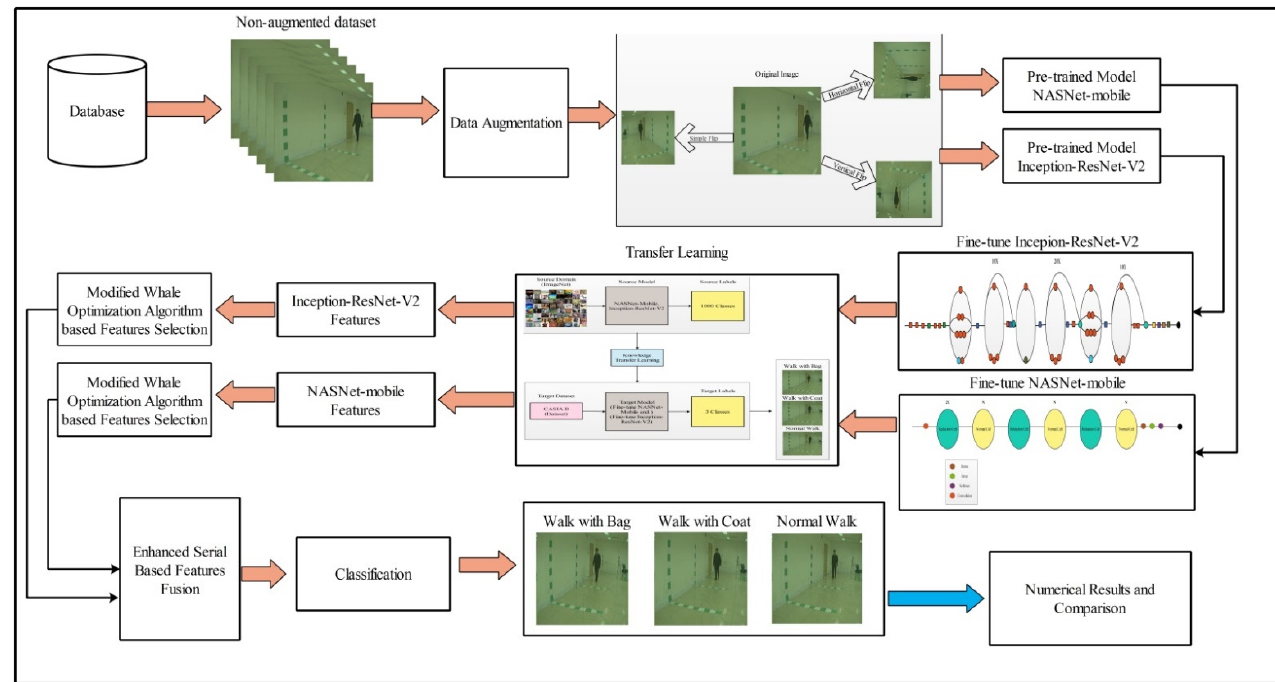
Figure 2. The main architecture of the proposed methodology for HGR.